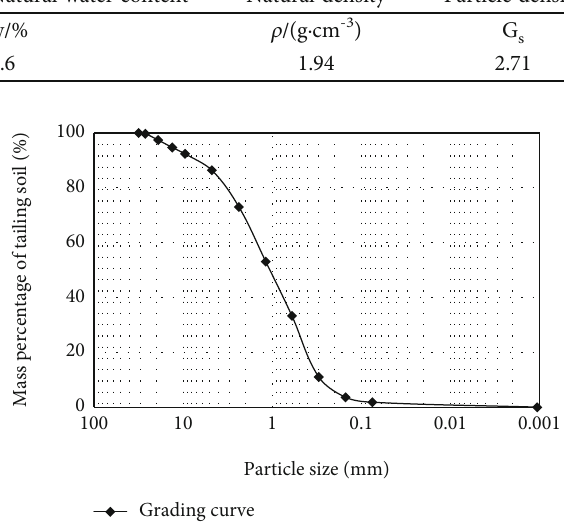
Figure 2: Grading curve of tailing